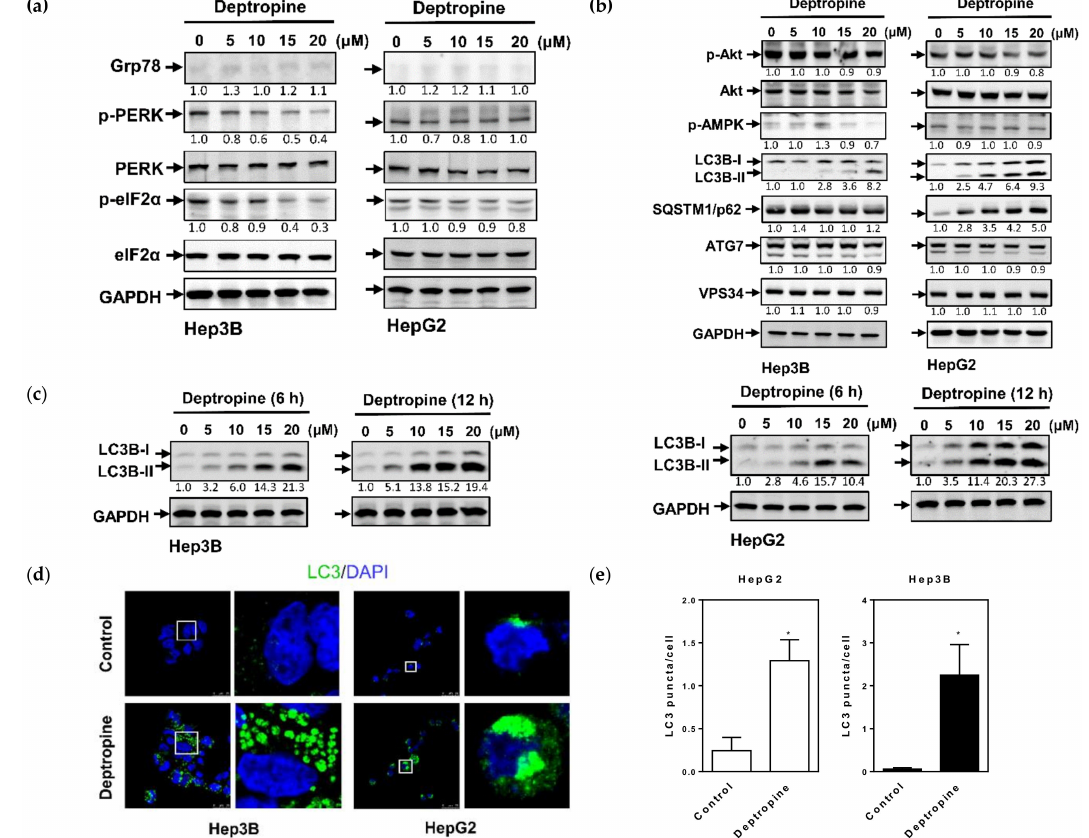
Figure 3. E ff ects of deptropine on marker protein expressions of endoplasmic reticular stress and autophagy, as well as the formation of light chain 3 (LC3) puncta, in human hepatoma cells. ( a , b ) Hep3B and HepG2 cells were treated with di ff erent concentrations of deptropine for 48 h, and the marker protein expressions of ( a ) endoplasmic reticular stress and ( b ) autophagy were determined by Western blotting. The relative intensity of each band (indicated below the bands) was normalized to the total protein (including protein kinase RNA-like endoplasmic reticulum kinase (PERK), eukaryotic translation initiation factor 2 subunit alpha (eIF2 α ), and protein kinase B (PKB, also known as Akt) or glyceraldehyde 3-phosphate dehydrogenase (GAPDH) loading control. Grp78, glucose-regulated protein 78; AMPK, adenosine 5 (cid:48) -monophosphate-activated protein kinase; SQSTM1, sequestosome-1; ATG7, autophagy related 7; VPS34, vacuolar protein sorting 34. ( c ) Hep3B and HepG2 cells were treated with di ff erent concentrations of deptropine for 6 or 12 h, and light chain 3B (LC3B) expression was determined by Western blotting. The relative intensity of LC3B-II was normalized to the GAPDH loading control and indicated below the bands. ( d , e ) HepG2 and Hep3B cells were treated with 20 µ M of deptropine for 24 h, and LC3 puncta were detected by immunofluorescence staining with an LC3-specific antibody (green) and nucleic acid staining with 4 (cid:48) ,6-diamidino-2-phenylindole (DAPI) (blue). ( d ) Representative immunofluorescence images are shown, and ( e ) quantification of LC3 puncta per cell is presented as the mean ± standard error. * p <